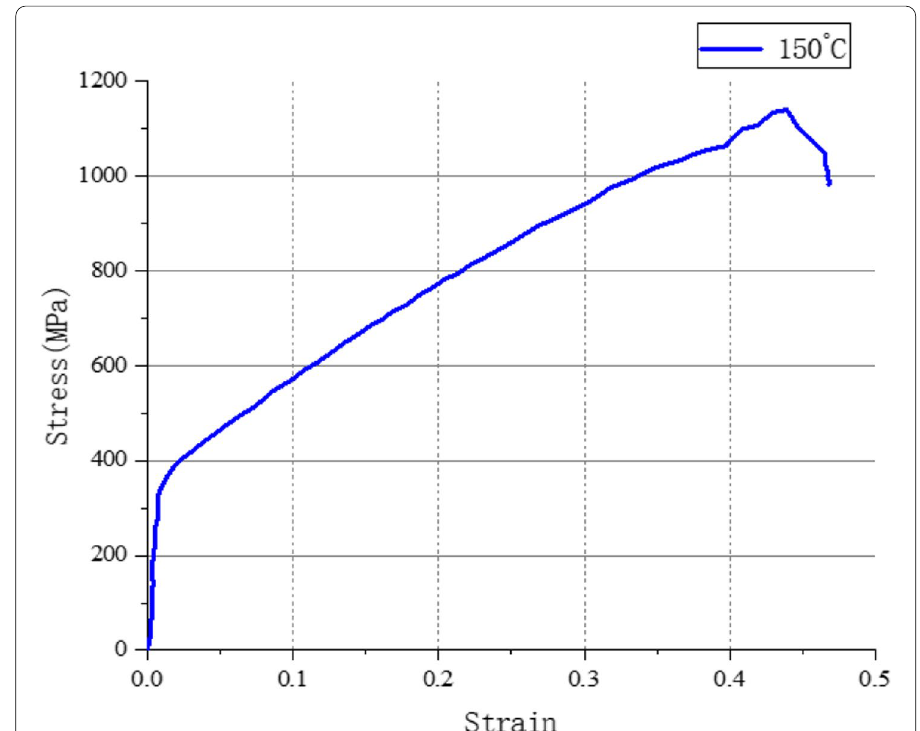
Fig. 1 Material characteristic curve of expansion liner